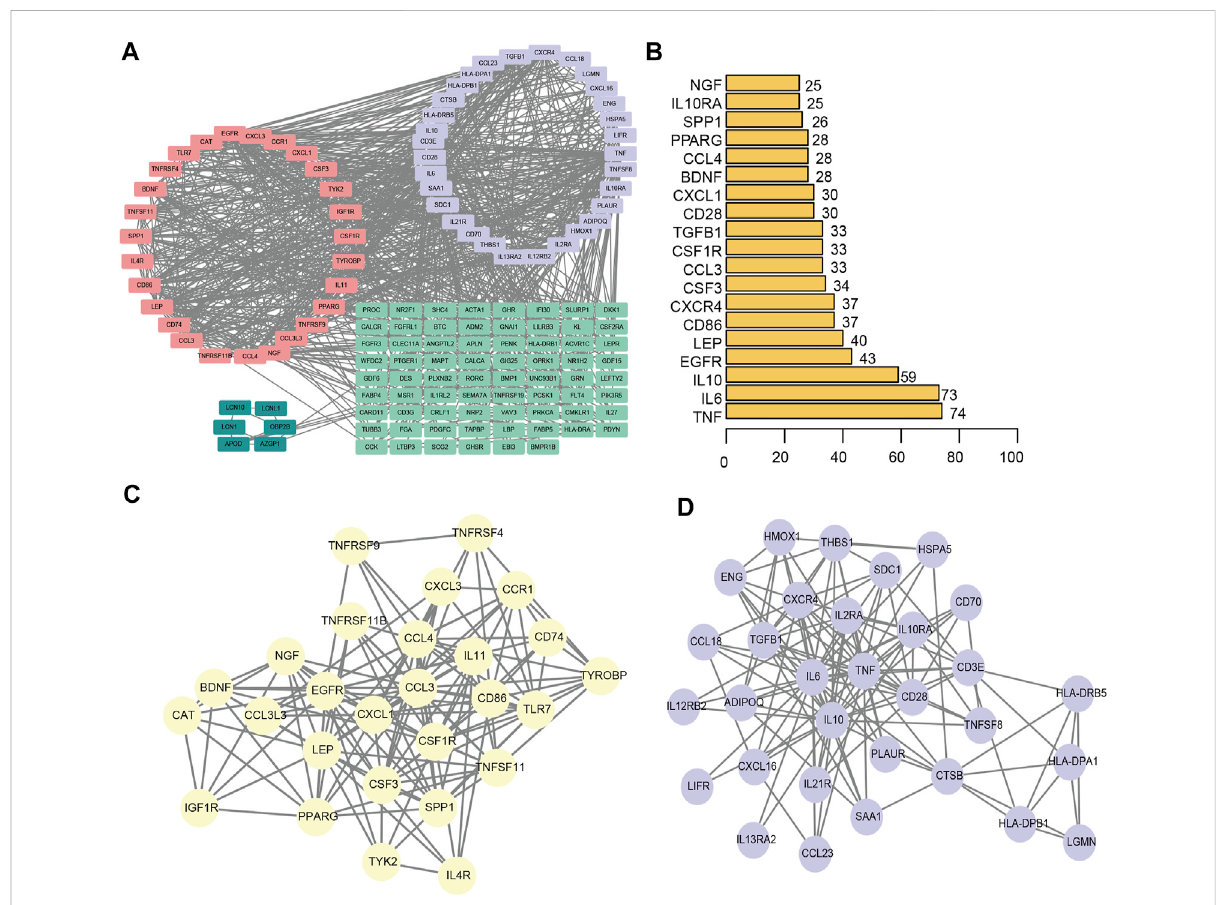
FIGURE 7 PPInetwork. (A) PPInetworkofDEGsassociatedwithLFHimmunity.Differentcolorsindicatedifferentmodules. (B) Thenumberofinteractions between the top 20 signi fi cant nodes in the PPI network and other genes; vertical coordinatesindicate the DEGs associated with LFH immunity, and the horizontal coordinates are the number of pairs of interactions between each of these DEGs and other genes. (C) MCODE identi fi ed key module 1 in the PPI network. (D) MCODE identi fi ed key module 2 in the PPI